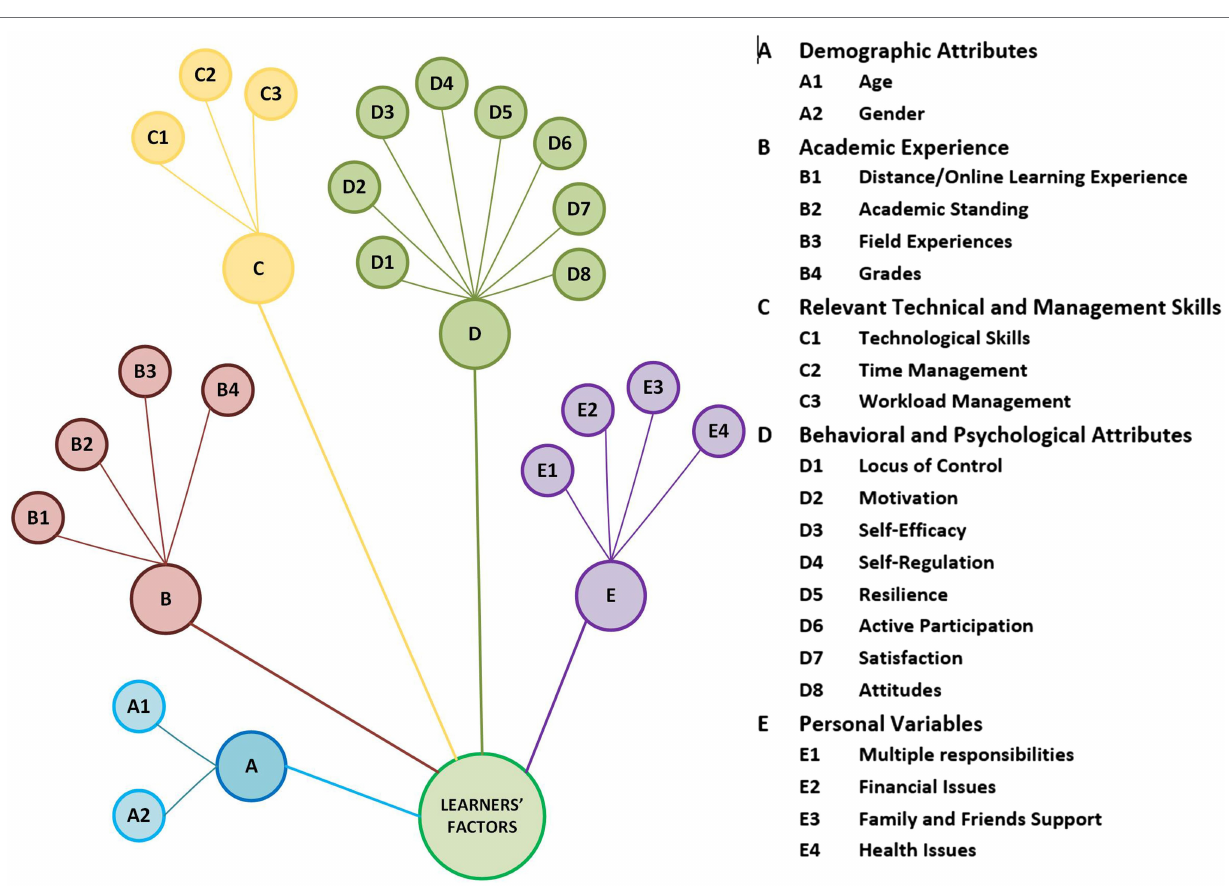
FIGURE 3 | Categorical arrangement of factors related to online